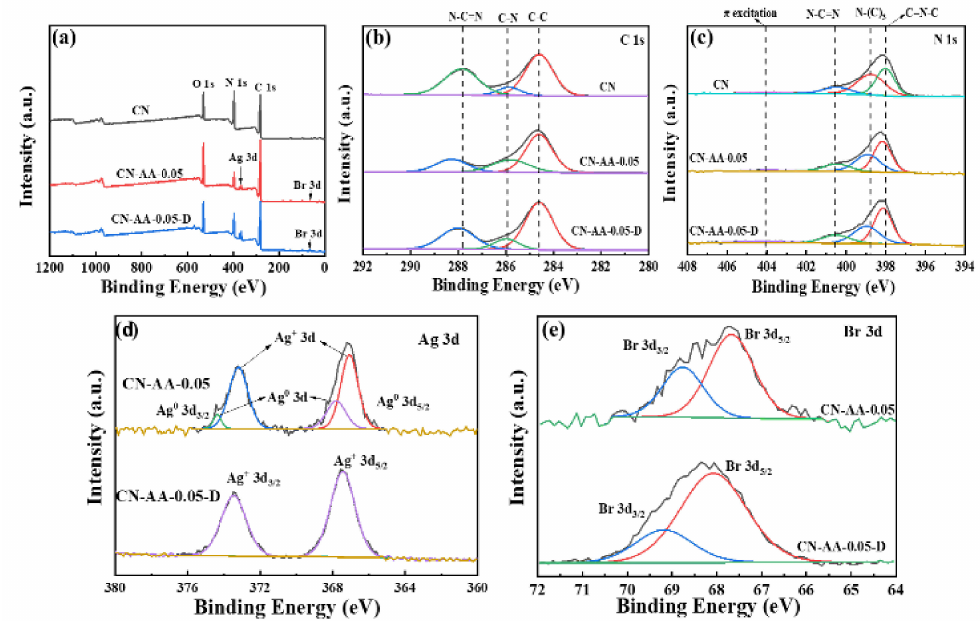
Figure 2. Full ( a ), C 1s ( b ), N 1s ( c ) XPS spectra of CN, CN-AA-0.05 and CN-AA-0.05-D; Ag 3d ( d ), Br 3d ( e ) XPS spectra of CN-AA-0.05 and